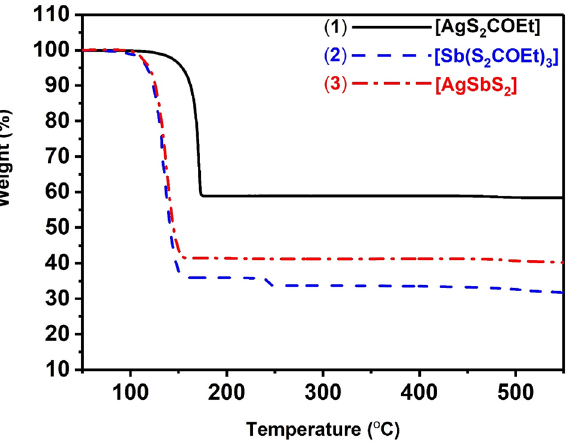
Figure 2. Thermogravimetric analysis (TGA) profiles of ( 1 ) [AgS 2 COEt], ( 2 ) [Sb(S 2 COEt) 3 ], and ( 3 ) mixtures of Ag and Sb xanthates to form AgSbS 2